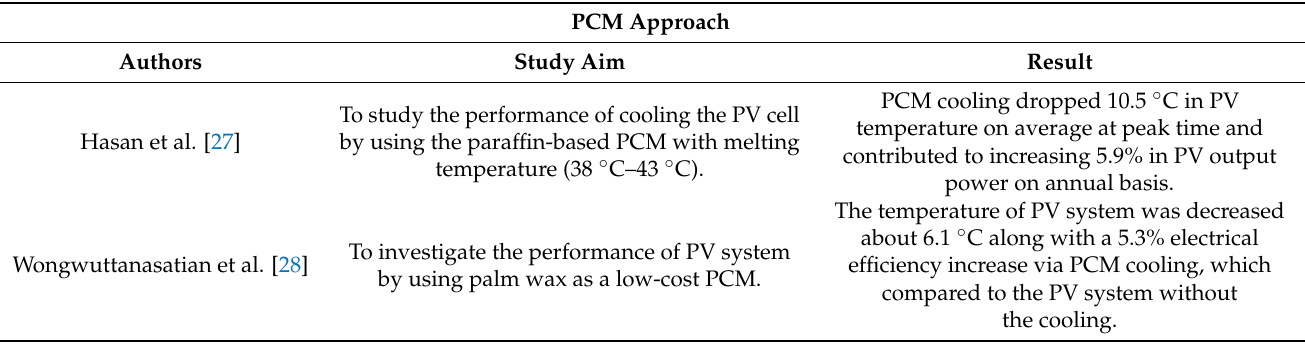
Table 2. A review of some studies on the passive cooling methods for PV